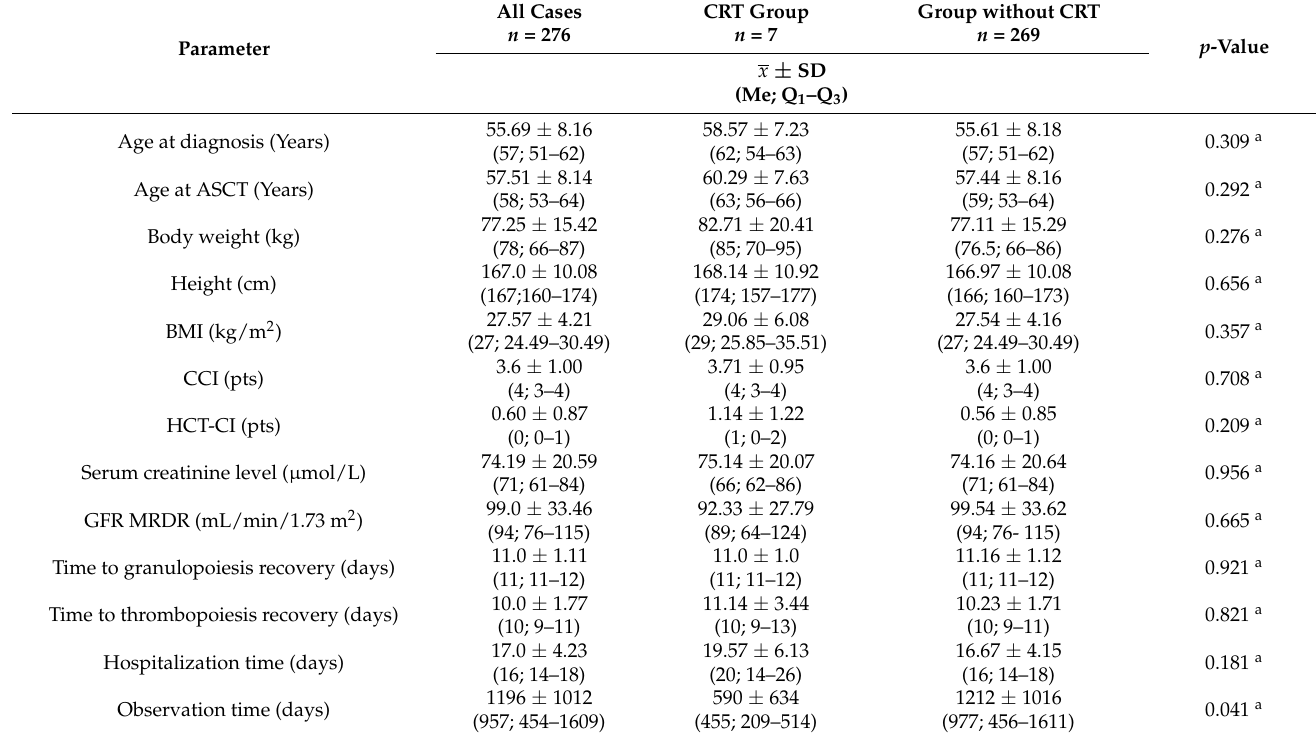
Table 1. Baseline patients’ characteristics and comparisons in the groups with/or without CRT, x ± SD (median; Q1–Q3).